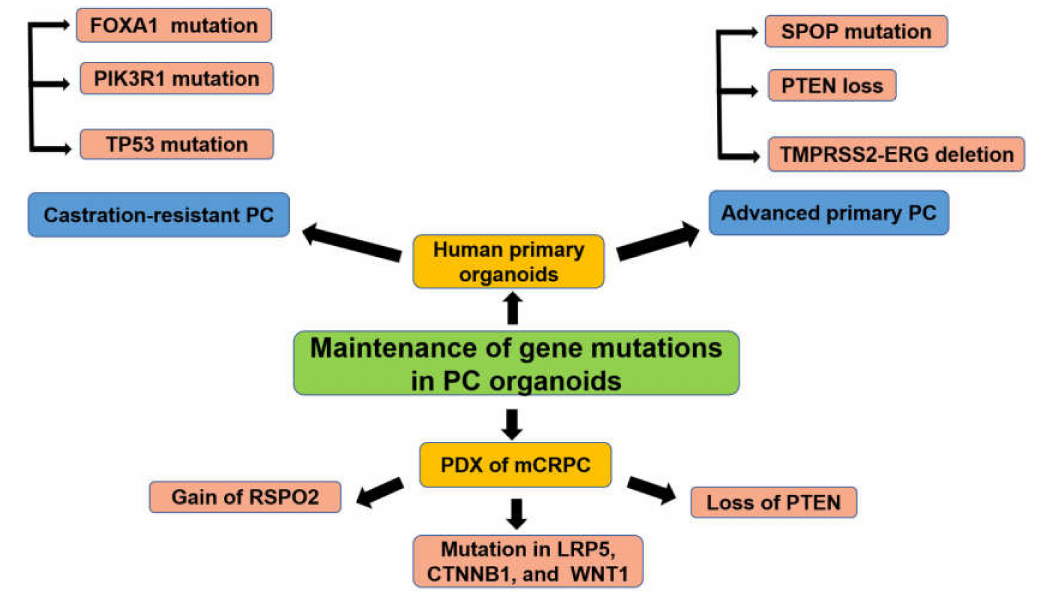
Figure 3. PC organoids for gene mutation screening. FOXA1: Forkhead box protein A1; PIK3R1: Phosphoinositide-3-kinase regulatory subunit 1; TP53: Total protein 53; SPOP: Speckle-type POZ protein; PTEN: Phosphatase and tensin homolog; TMPRESS2: Transmembrane protease, serine 2; ERG: Erythroblast transformation-specific-related gene; RSPO2: R-spondin 2; LRP5: Low-density lipoprotein receptor-related protein 5; CTNNB1: Catenin beta 1; WNT1: Wingless-type MMTV integration site family, member